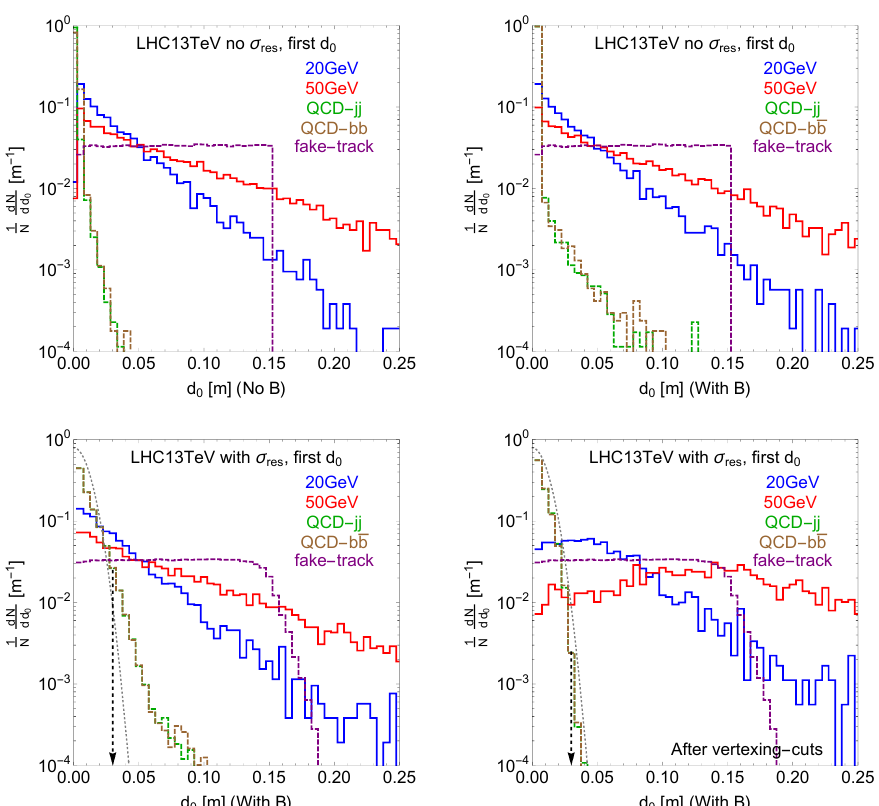
Figure 10 . The transverse impact parameter d 0 distributions for QCD background, fake-track background and the signal. This figure is similar to figure 6, but only the leading track distribution is